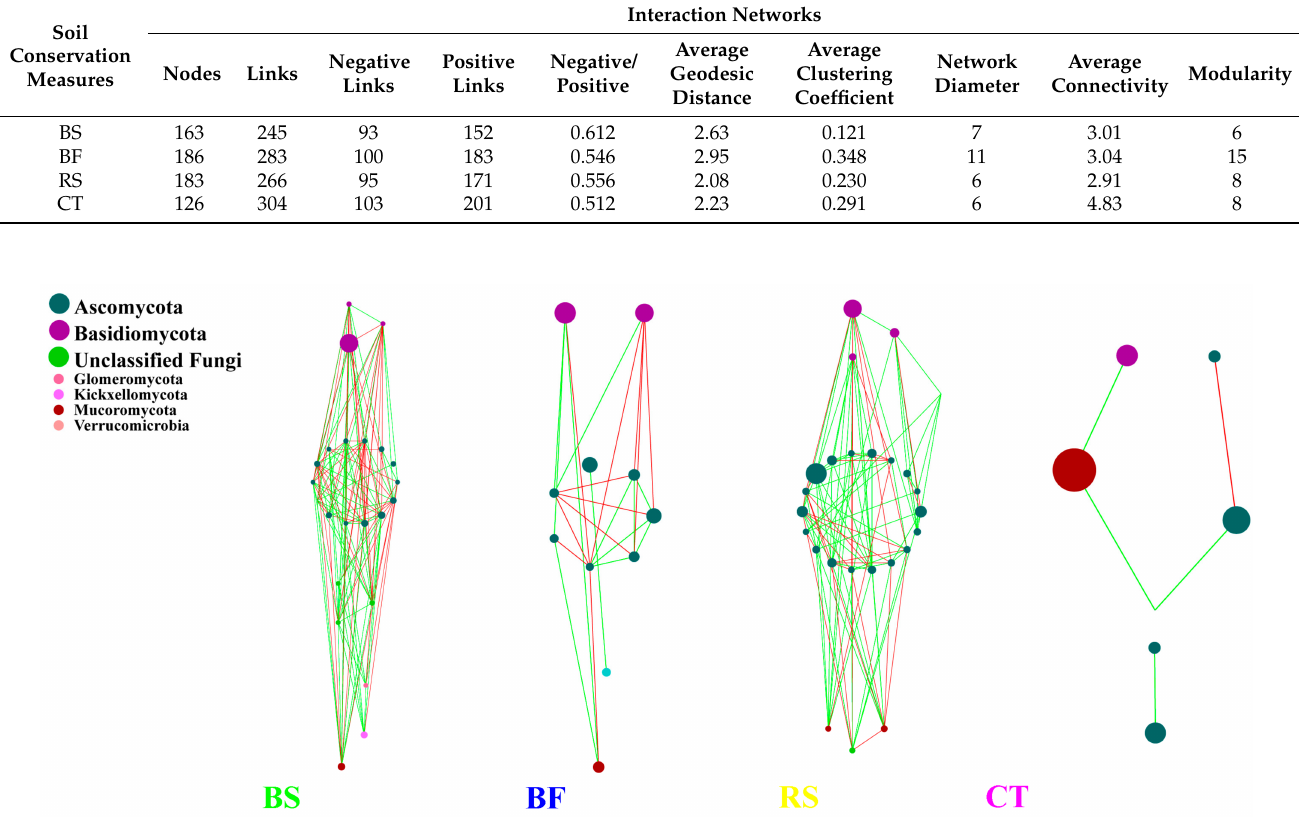
Figure 9. Molecular ecological networks of fungal communities under different soil and water conservation measures. Green and red lines respectively denote significant positive (Spearman correlation, p < 0.05, r > 0.8) and negative linear (Spearman correlation, p < 0.05, r < − 0.8) relationships. The size of the circles represents the relative abundance of fungi. Table 6. Parameters of interaction networks of fungal communities under different soil and water conservation measures. Soil Conservation